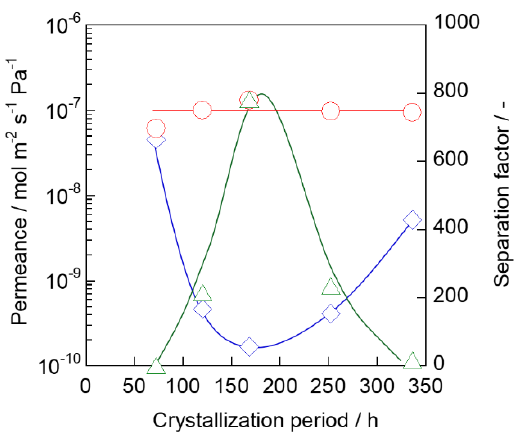
Figure 7. Permeances of C 6 hydrocarbons through silicalite-1 membranes with different crystallization period. O, n -hexane; , 2,2-dimethylbutane; (cid:52) , separation factor. (cid:51)